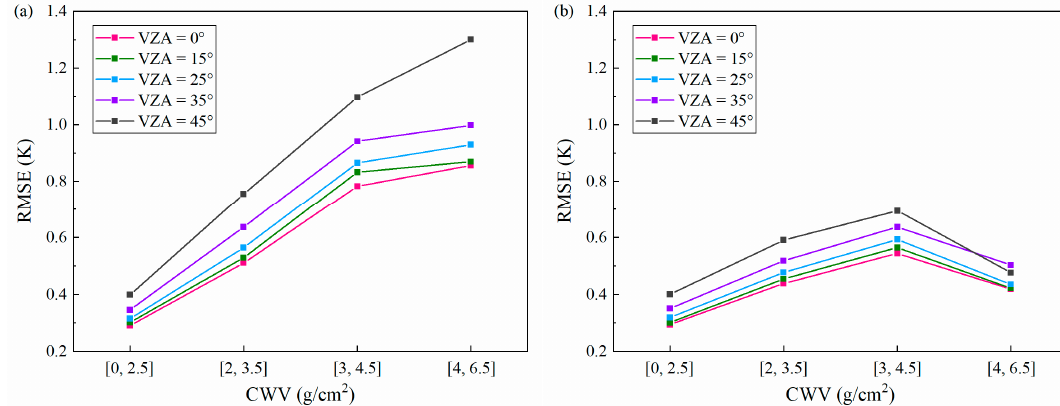
Figure 5. Variation of the temperature RMSE (without noise) as the column water vapor (CWV) changes under different VZAs for ( a ) daytime algorithm and ( b ) nighttime algorithm.